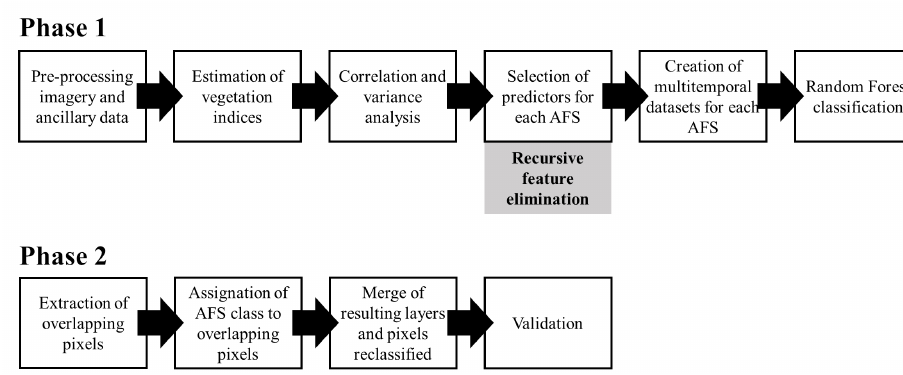
Figure 3. Methodology for the identification of AFS classes.